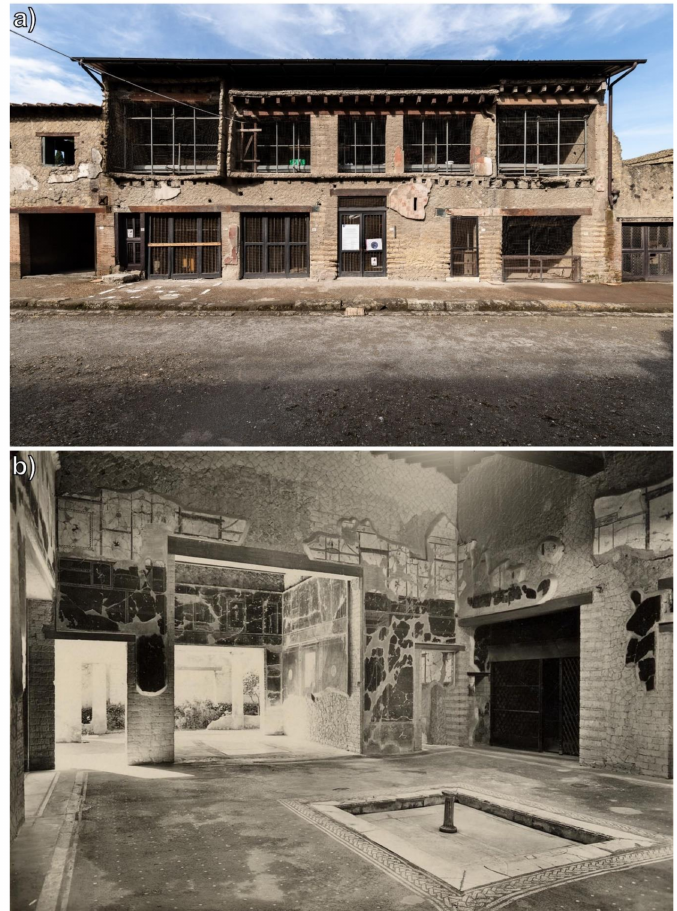
Figure 1. ( a ) Exterior of the House of the Bicentenary (Photo: Scott Warren); ( b ) View of the tablinum of the House of the Bicentenary (1938–1939) from the atrium at the time of excavation [17]. The tablinum exhibits a sophisticated decorative scheme dating to ca. 50 AD, with typi- cal Fourth Style wall paintings and a mosaic pavement in red, yellow, and black. The painted scheme is divided into three horizontal sections (registers) that exhibit red and yellow backgrounds, separated by a frieze and vertical decorated bands with black